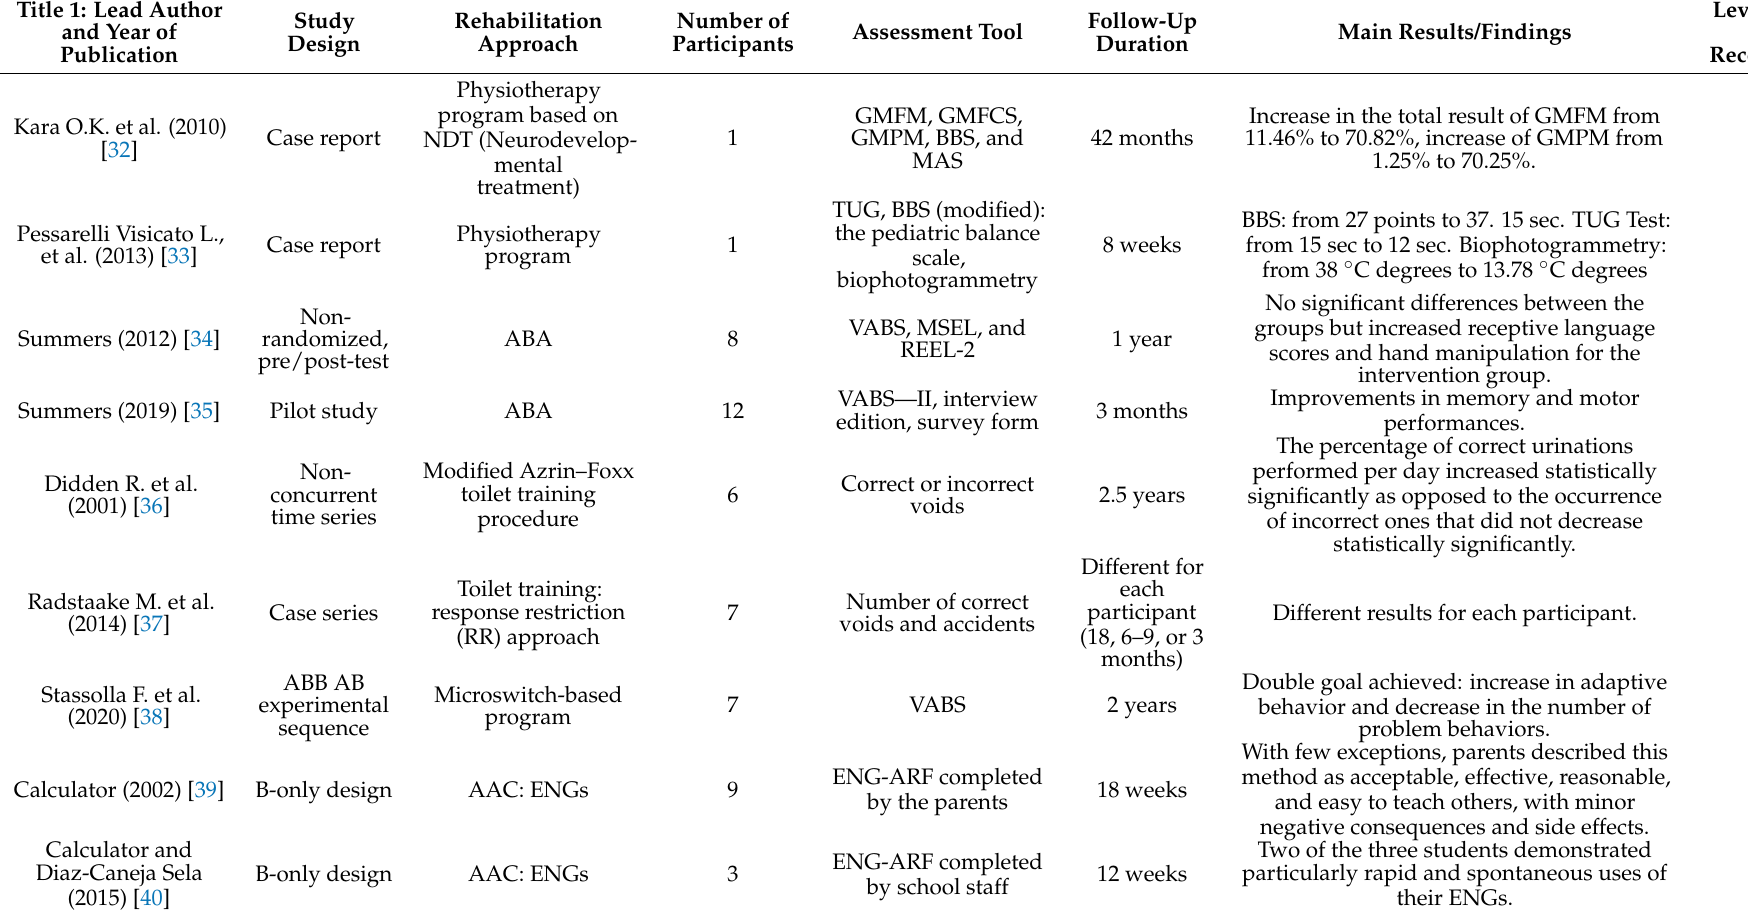
Table 1. Summary of the studies included in the